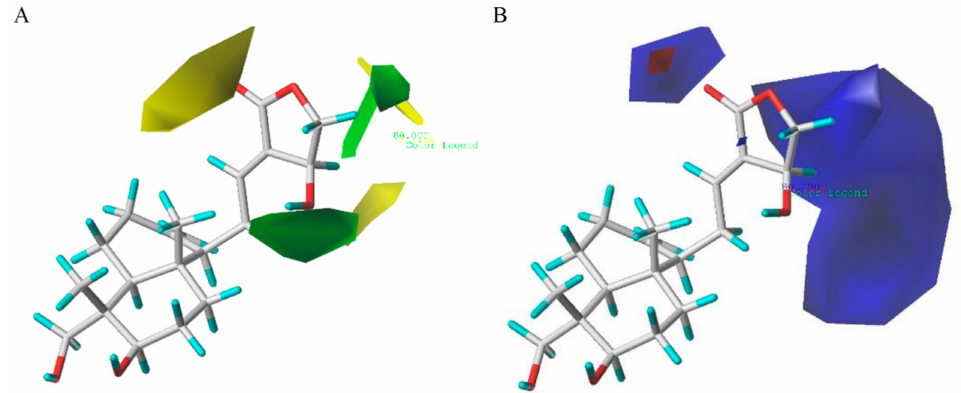
Figure 5. CoMFA Std*Coe ff contour maps in combination with compound AP-6 in group 1. ( A ) Steric field: green and yellow contours indicate regions where bulky groups enhance or reduce the activity, respectively. ( B ) Electrostatic field: blue and red contours indicate regions where electron-donating and electron-withdrawing groups enhance the potency,